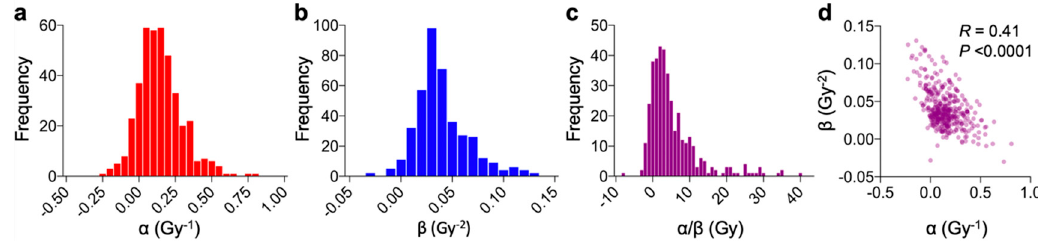
Figure 1. Frequency histograms of the LQ parameters α ( a ), β ( b ), and α / β ( c ), and a scatter plot showing correlation between α and β ( d ). R value and p value assessed by Spearman’s rank correlation test are shown.